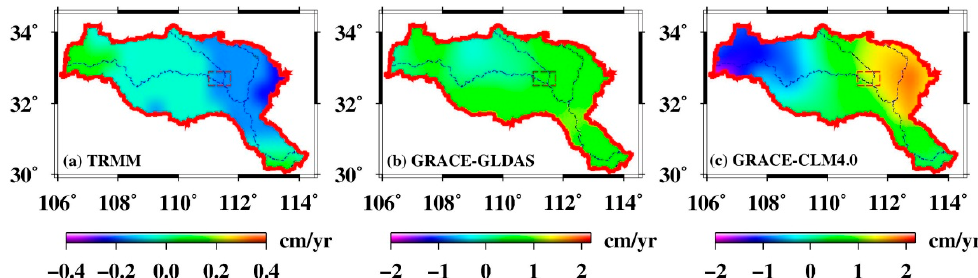
Figure 8. ( a ) Trends of the changes in precipitation from the TRMM, ( b ) total surface water storage from GRACE-GLDAS, and ( c ) human-induced surface water storage from GRACE-CLM4.0 during the period of 2003–2015.